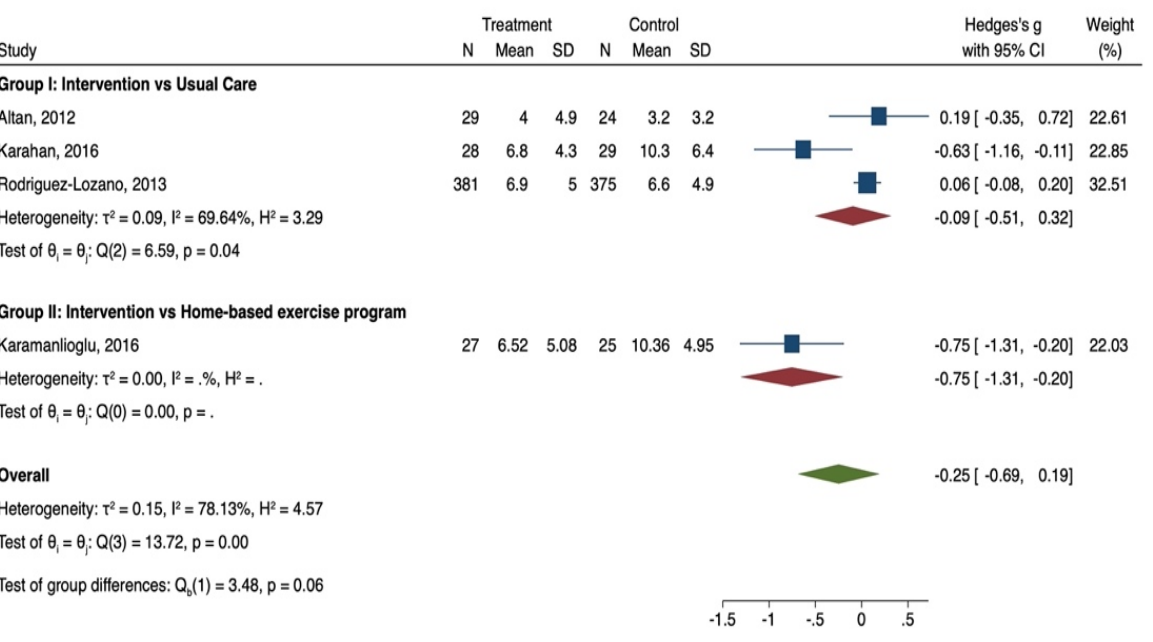
Figure 7. ASQoL—Forest Plot.